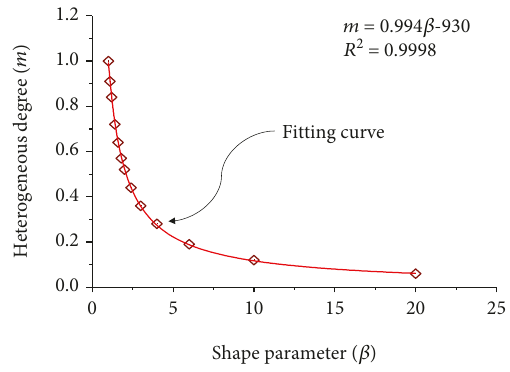
Figure 11: The relationship between the shape parameter β and the inhomogeneous parameter m